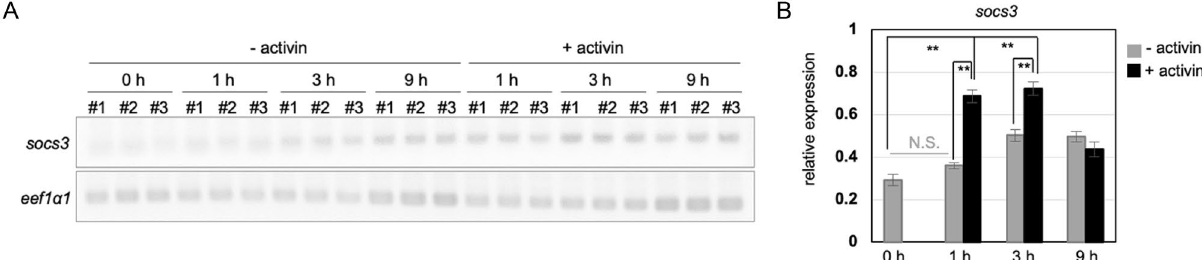
Figure 5. Upregulation of socs3 in ACs following activin A treatment. Semiquantitative RT-PCR of the expression of socs3 in ACs. Dissected ACs were cultured with or without of activin A. ( A ) Electrophoresis gel of RT-PCR products. #1–3 indicate the three biological replicates. The upper panel shows the expression of socs3 and the lower panel shows the expression of eef1a1 , which was used as the loading control. Full size images of each gel are presented in Supplementary Figure S10. For ( B ), the densitometry for socs3 expression. Error bars indicate s.e.m. (n = 3). ** p < 0.01, p -value was calculated using Student’s t-test after the one-way analysis of variance. N.S., not significant. ( A , B ) Cultivation times are indicated as follows: 0 h, 0 h (the absence of cultivation); 1 h, 1 h; 3 h, 3 h; 9 h, 9